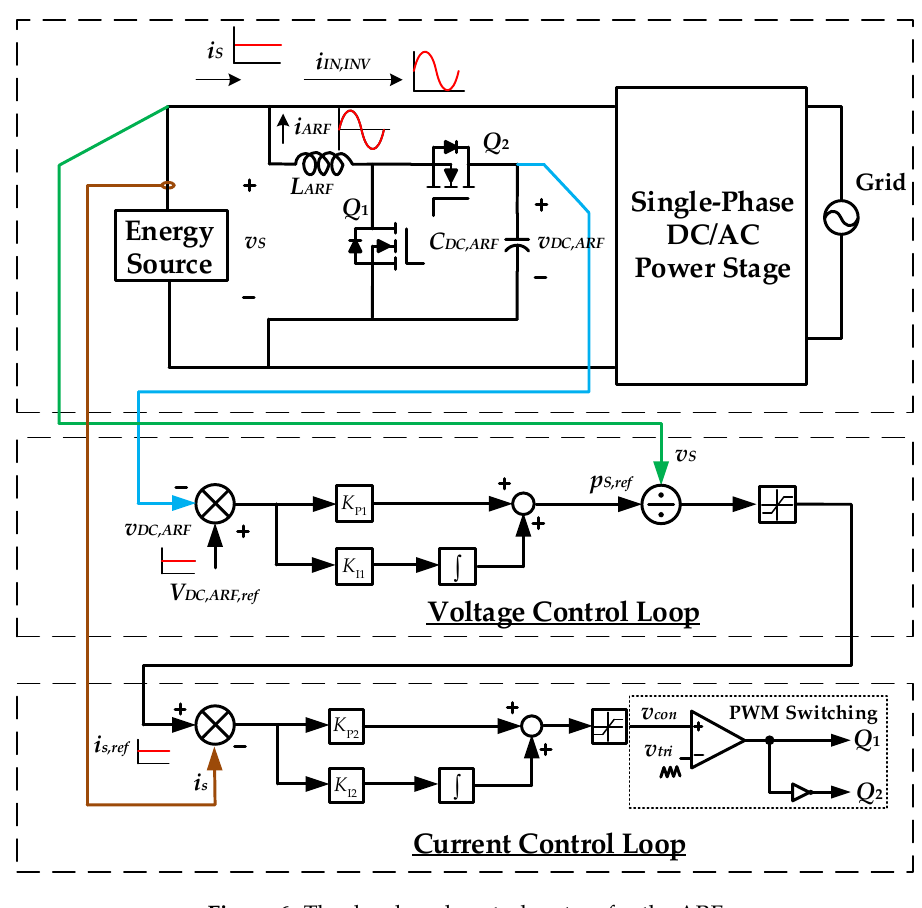
Figure 6. The developed control system for the ARF. Energies 2020 , 13 , x FOR PEER REVIEW